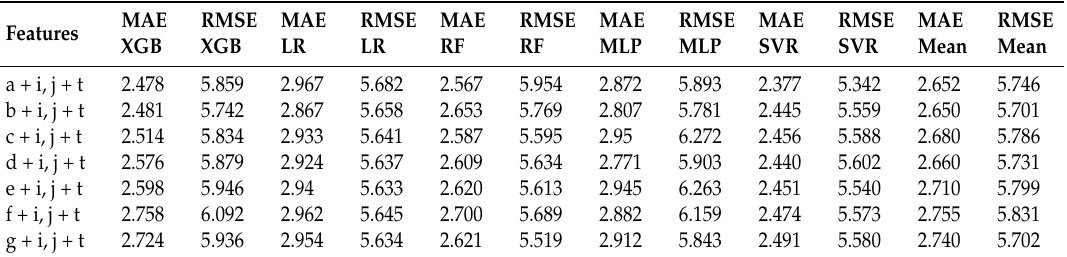
Table 3. RMSE and MAE using the same feature sets as Table 2 plus time stamp, using five different machine-learning techniques.